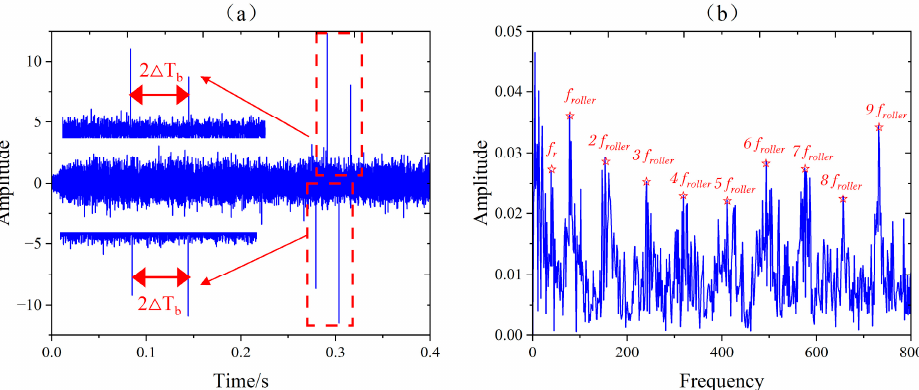
Figure 22. The outcomes produced by MDMVO-MCKD adaptively enhancing the roller fault pulse: ( a ) The best deconvoluted signal, and ( b ) its envelope spectrum.